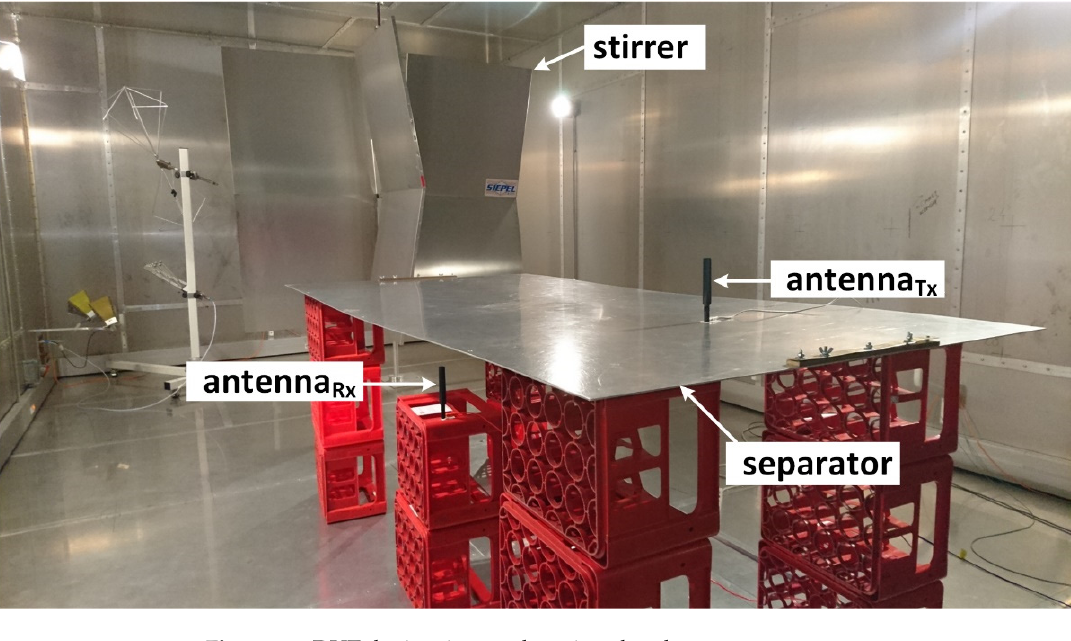
Figure 10. DUT devices in reverberation chamber.